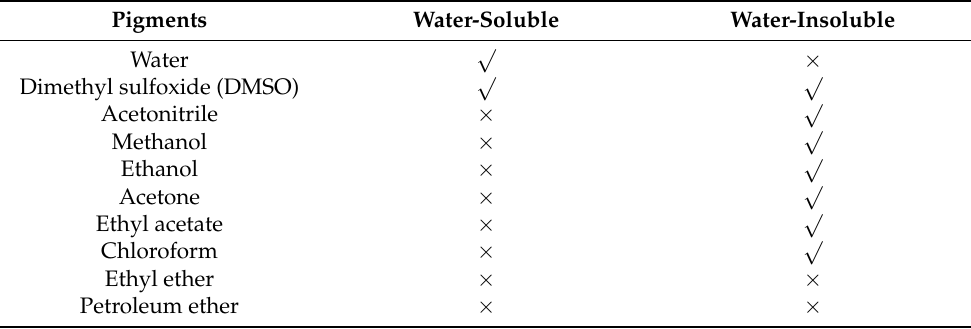
Table 7. Solubility of water-soluble and water-insoluble gardenia blue pigments. Pigments Water-Soluble